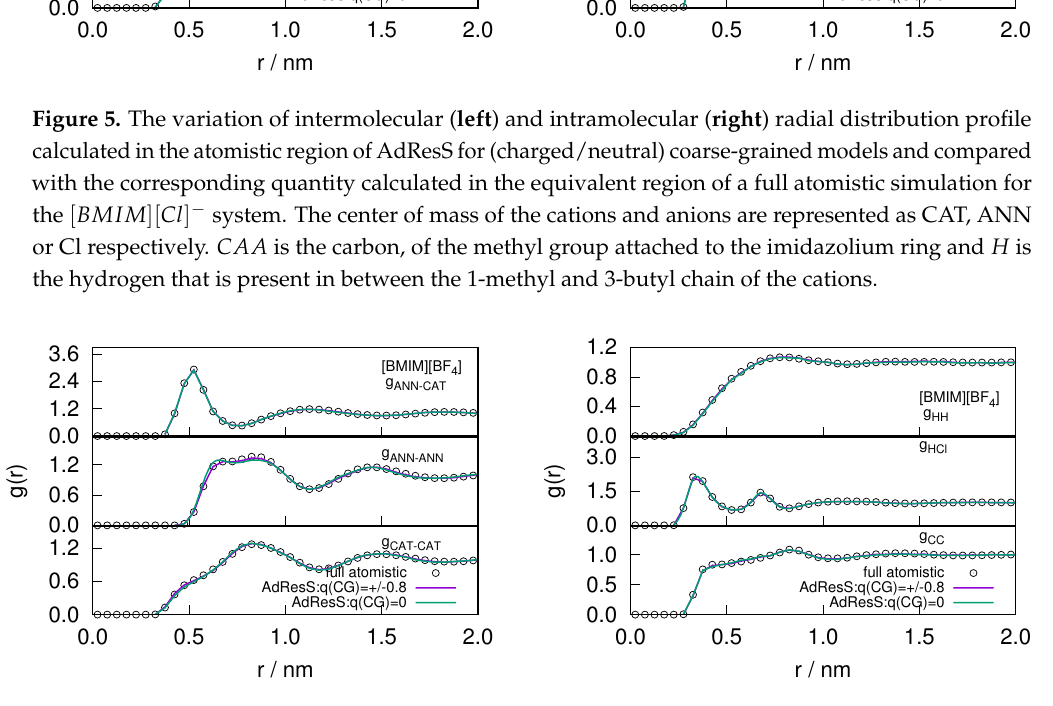
Figure 6. The variation of intermolecular ( left ) and intramolecular ( right) radial distribution profile calculated in the atomistic region of AdResS for (charged) coarse-grained models and compared with the corresponding quantity calculated in the equivalent region of a full atomistic simulation for the [ BMIM ][ BF ] − 4